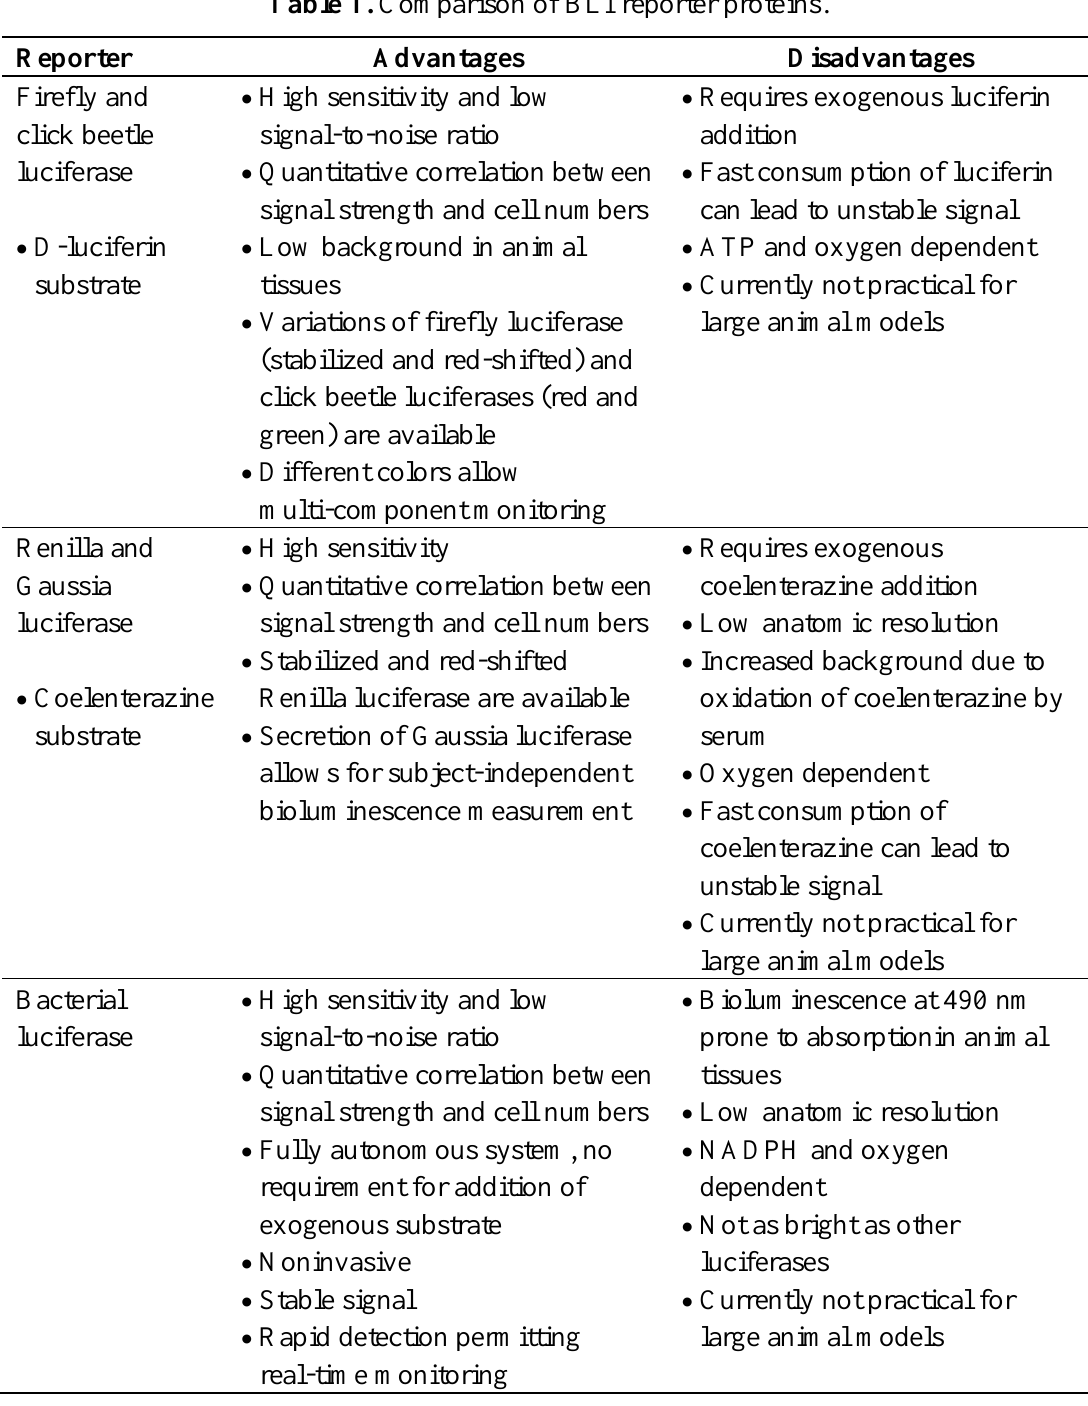
Table 1. Comparison of BLI reporter